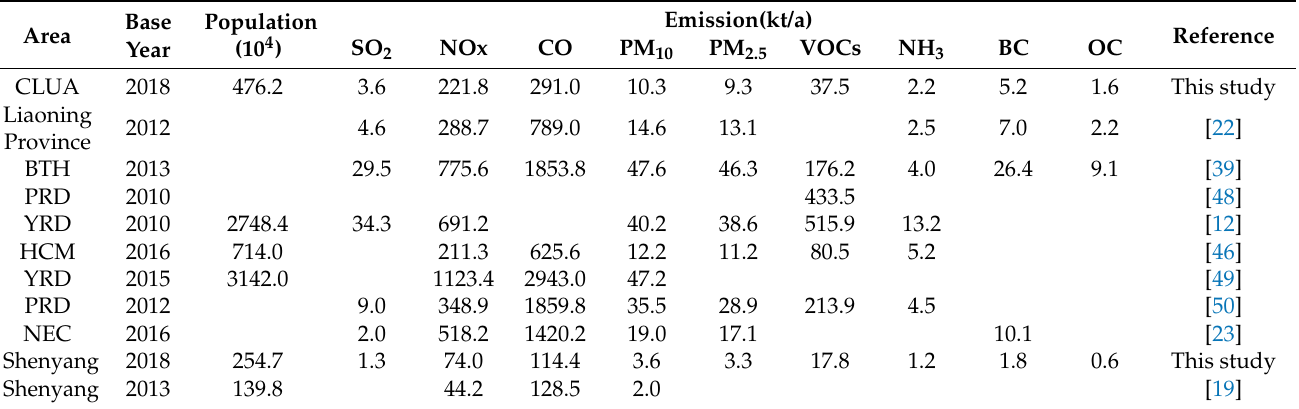
Table 4. Comparison of vehicle emission inventories among the CLUA and other domestic